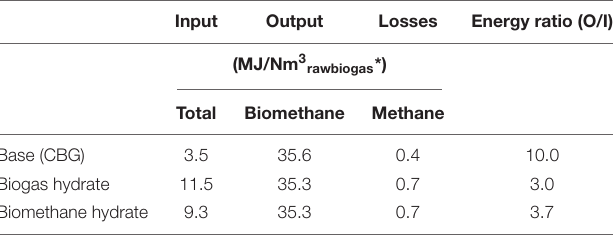
TABLE 4 | Primary energy (PE) inputs, outputs and losses, and energy ratio (O/I) for the three scenarios studied.